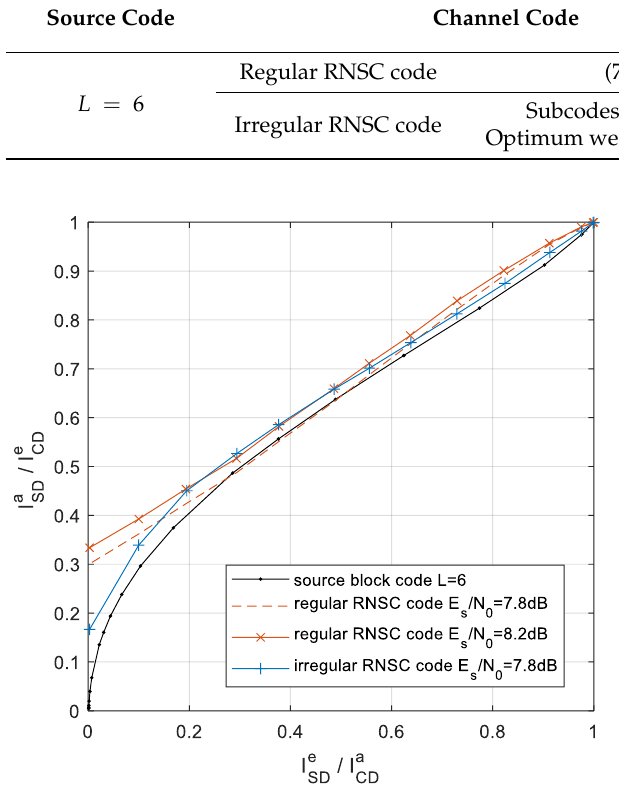
Figure 5. Exit curve of optimized channel code for the source code with L = 6.